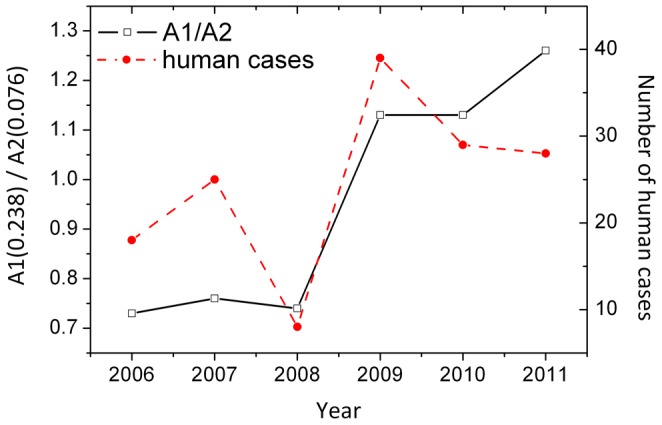
Correlation between A(0.236)/A(0.076) values of Egyptian H5N1-HPAIV and human cases.The total average A(0.236)/A(0.076) values and the number of human cases in Egypt between 2006 and 2010 are shown.